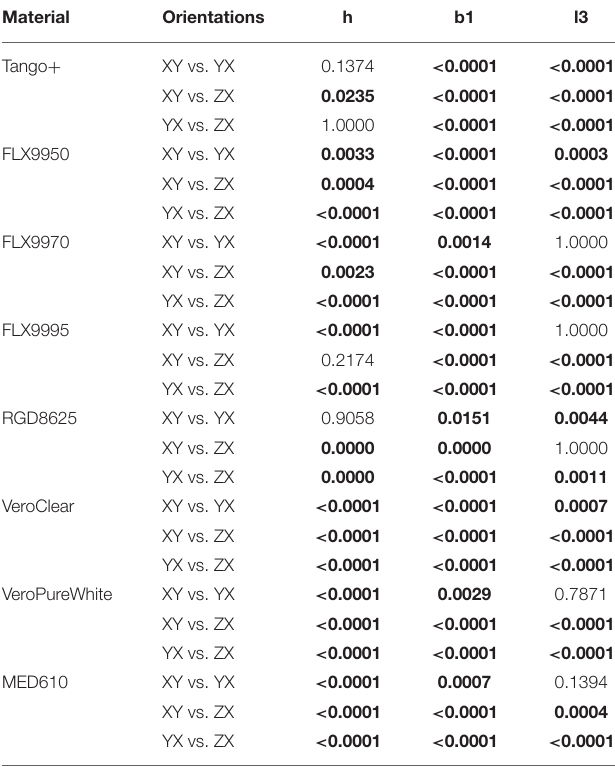
P-values, showing significant differences between the compared groups are shown in bold.